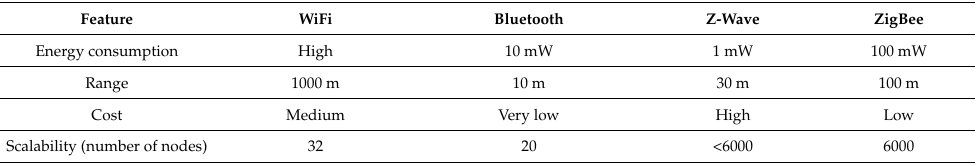
Table 7. Communication technologies comparative.